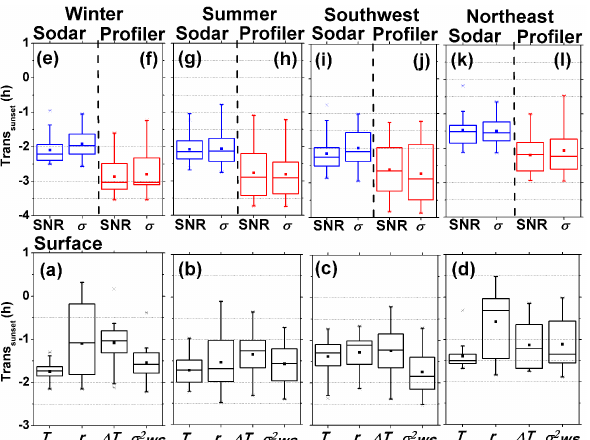
Figure 4. Variation of mean Trans sunset as obtained by different state variables for different thresholds, depicting the sensitivity of thresholds used in the present study to the start time of the transition.